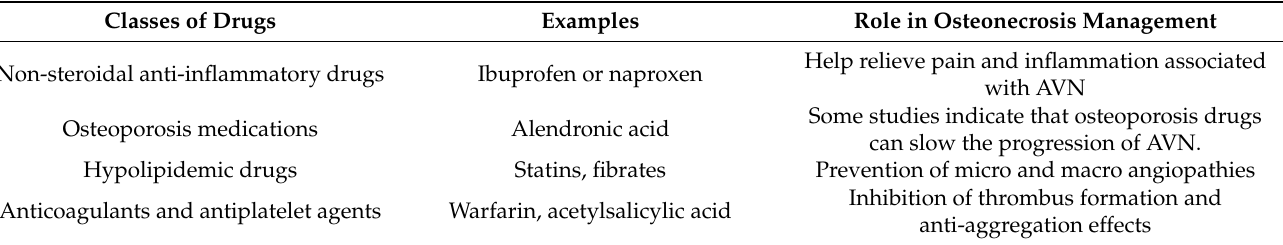
Table 2. Medications used in the treatment of AVN [12,17,20].